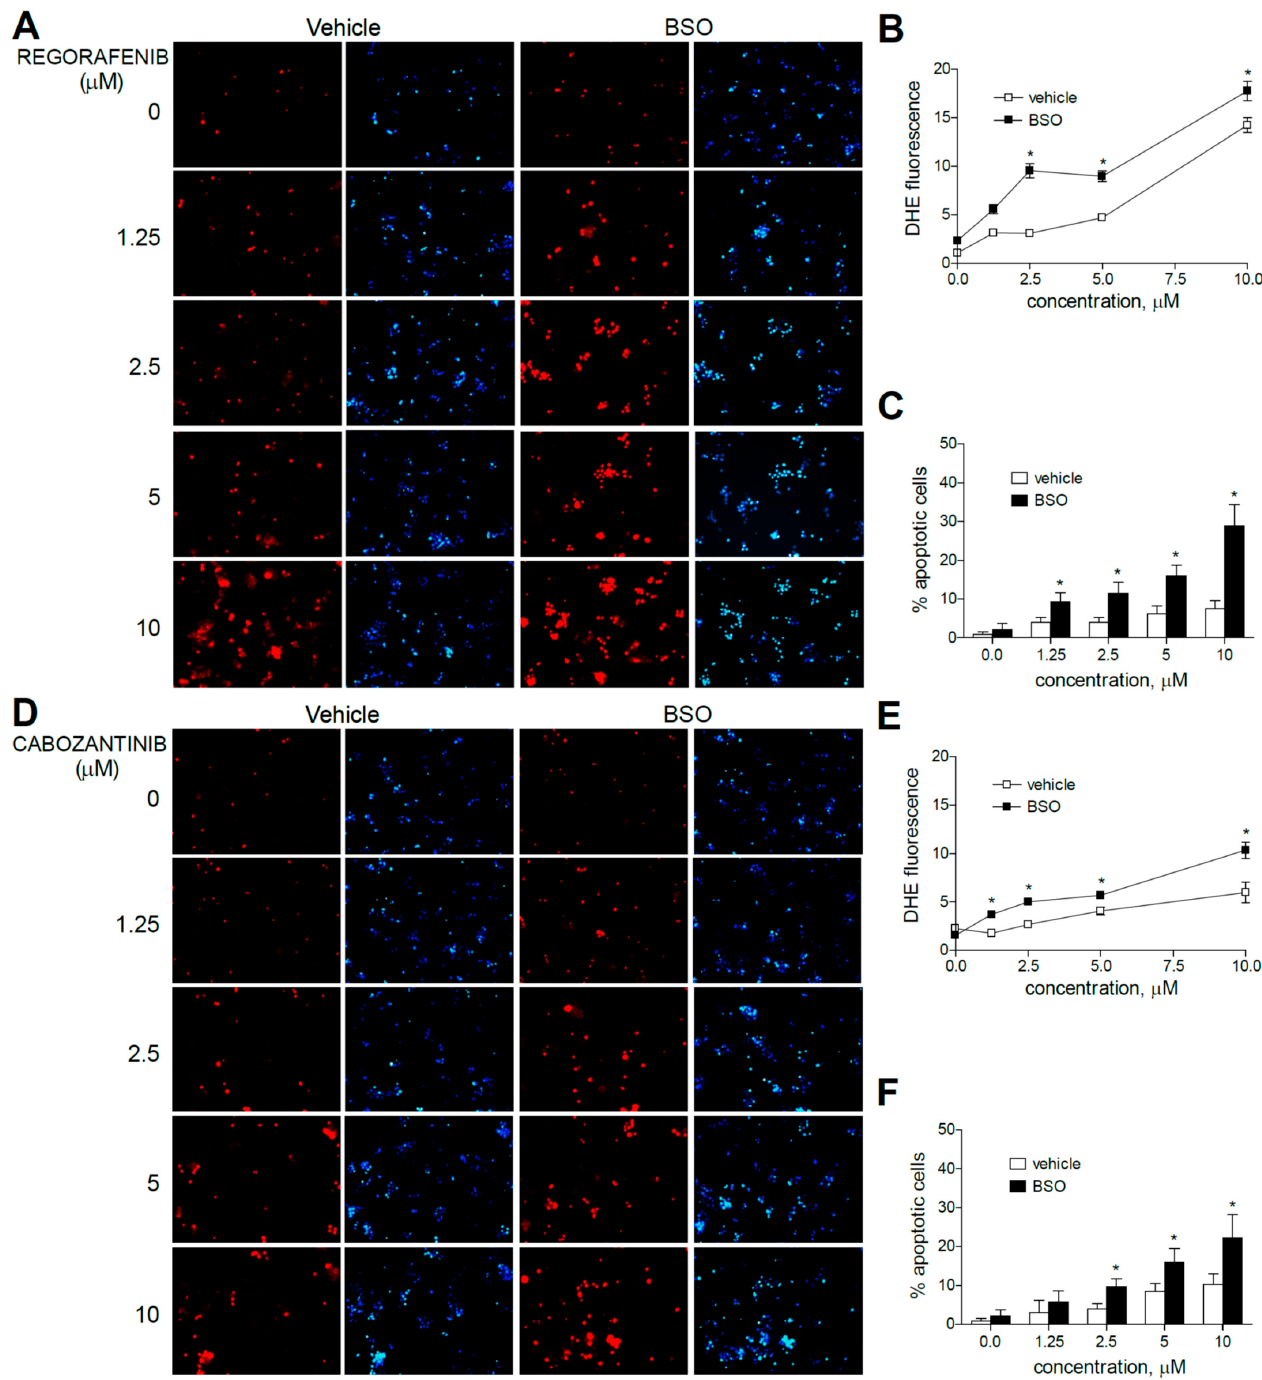
Figure 3. Superoxide production, increased by MKI treatment, is enhanced by GSH reduction. Representative fluorescence images ( n = 10) after superoxide detection (DHE, red) and nuclear (Hoechst 33258, blue) staining of HepG2 cells after regorafenib ( A ) or cabozantinib ( D ) at increasing concentrations. ( B , E ) Quantification of DHE fluorescence in MKI-treated cells was measured using Image J software. ( C , F ) Number of apoptotic cells was counted ( n = 3). * p < 0.05 vs. control.